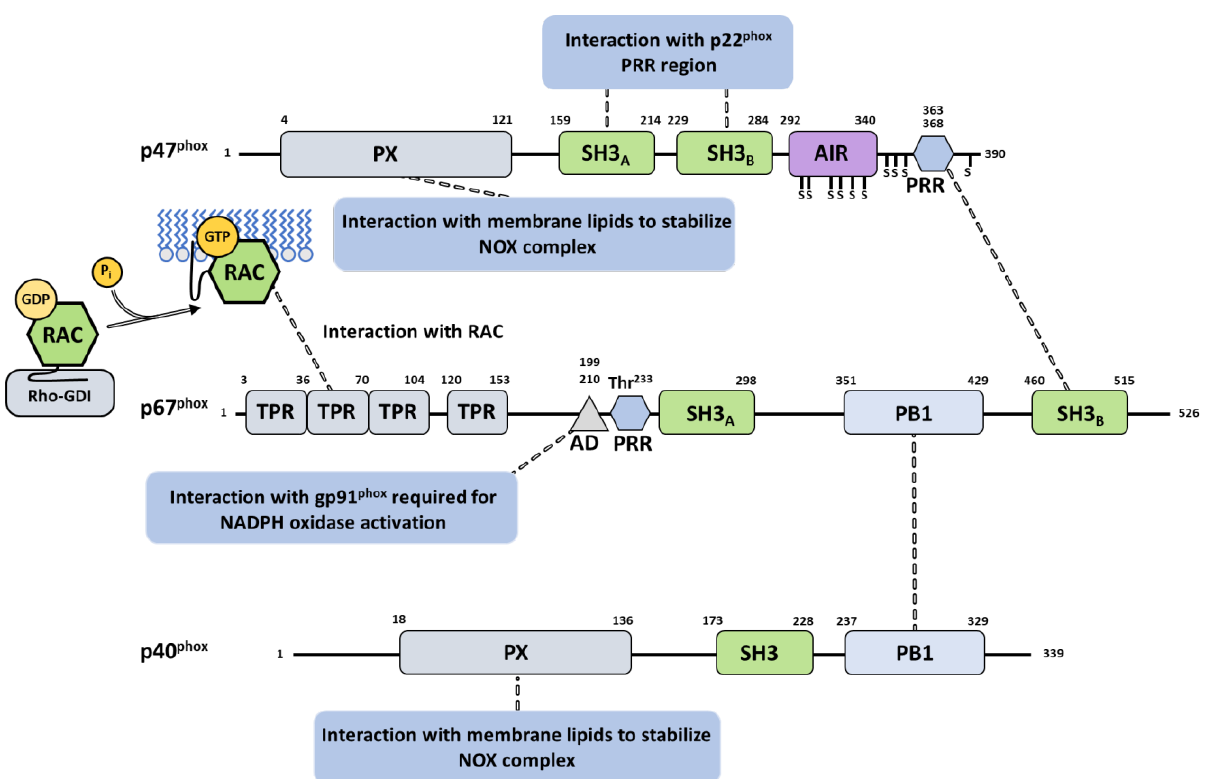
Figure 6. Diagram of the cytosolic factors of NADPH oxidase and their interactions with partners. The p47 phox and p40 phox proteins are initially self-inhibited and require phosphorylation to reach an active conformation. The p67 phox and p40 phox factors interact through their respective PB1 domains; the SH3B domain of p67 phox binds to the PRR domain of p47 phox . After phosphorylation, the bis-SH3 domain of p47 phox is unmasked, triggering translocation of the p47 phox –p67 phox –p40 phox trimeric complex via interaction with the PRR domain of p22 phox . At the membrane, the PX domains of p47 phox and p40 phox bind to membrane lipids. Rac-GDP sequestered in cytosol by RhoGDI is transferred to the membrane and GDP is exchanged for GTP, leading to the interaction with the TPR domain of p67 phox . Domain boundaries are indi-cated by position numbers. Important phosphorylation sites in the AIR region of p47 phox are indicated as ‘S’; the major phosphorylation site of p67phox Thr233 is labeled. Dotted lines represent the inter-domain interactions. Adapted from [110].